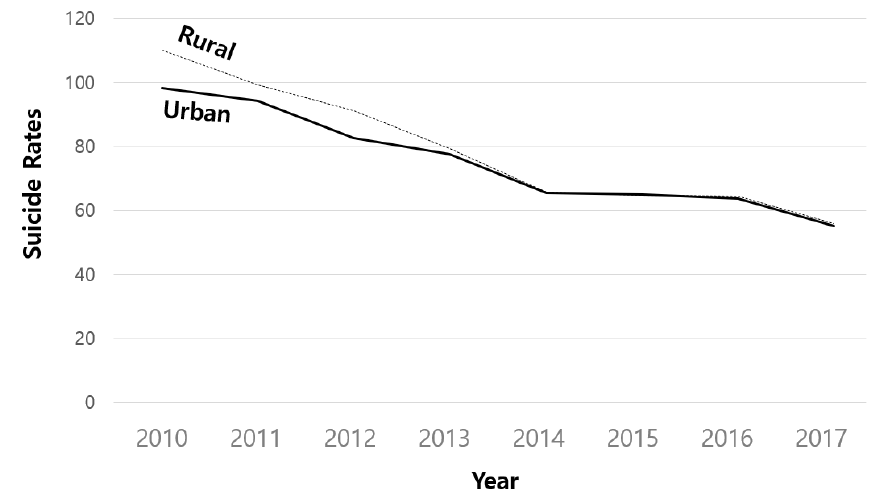
Figure 3. Suicide rate of older adults by region.